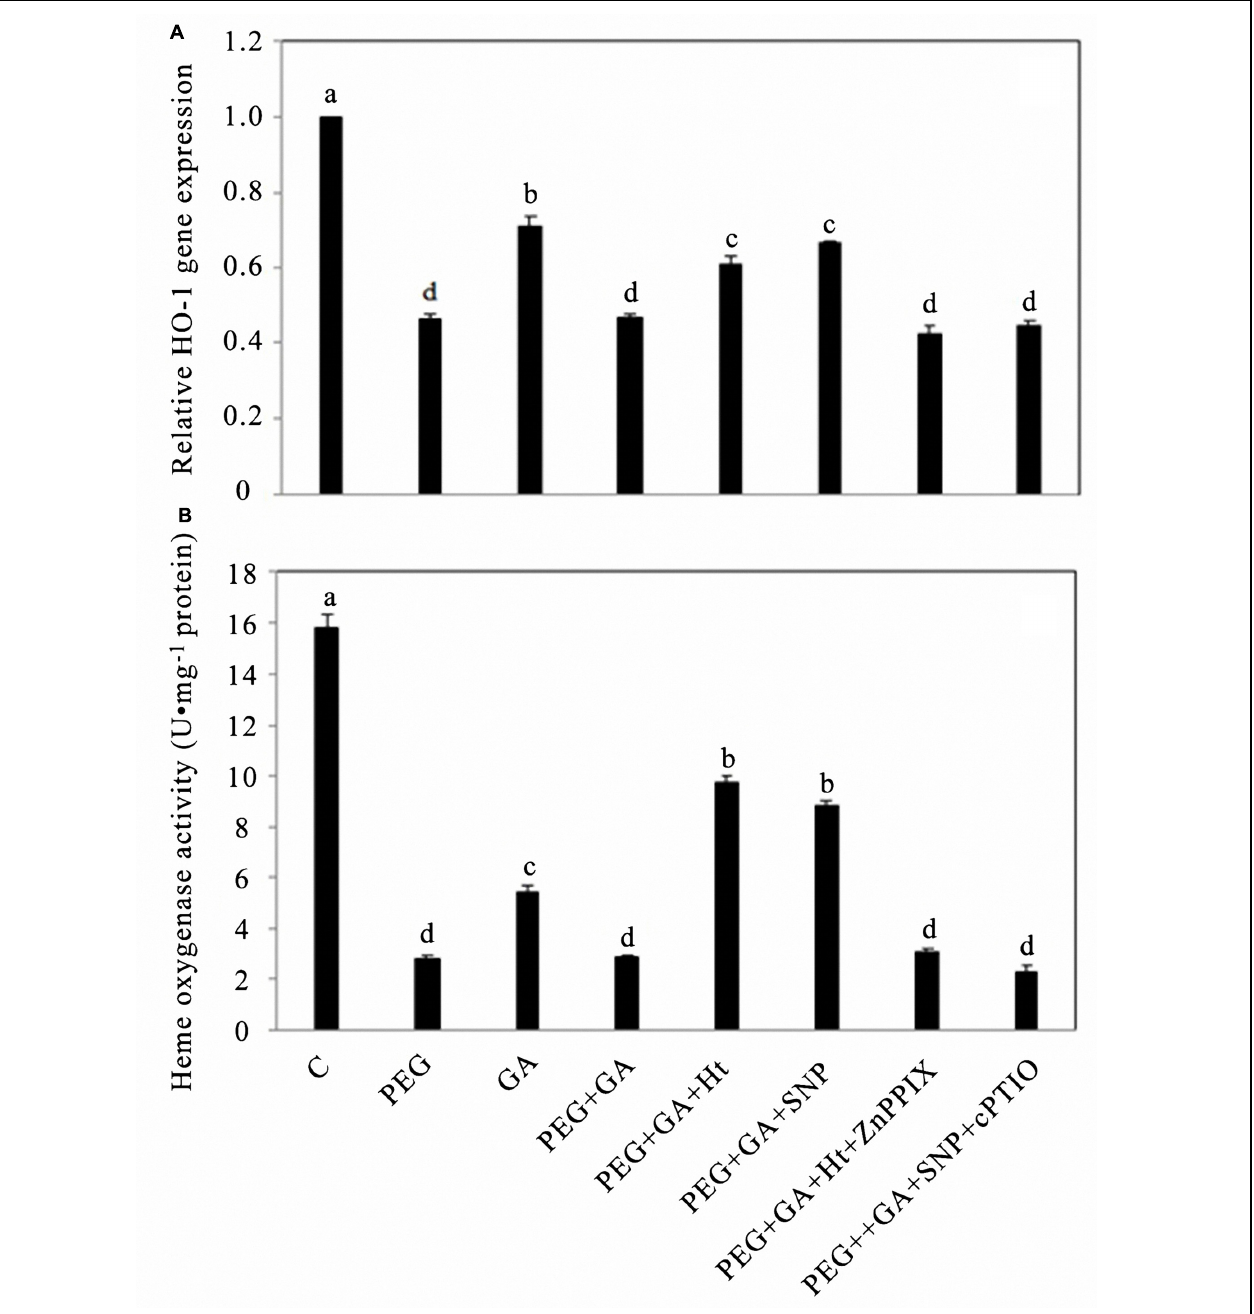
FIGURE 3 | Ht, SNP, ZnPPIX, and cPTIO up- or down-regulated the expression of HO-1 and the activity of HO in GA-induced rice aleurone layers subjected to drought stress. Aleurone layers treated with or without 20% PEG, 50 μ M GA, 1 μ M Ht, 200 μ M SNP, 10 μ M ZnPPIX, and 200 μ M cPTIO alone or in combination for 24 h. A sample with distilled water treatment was used as control (C). The transcript levels of HO-1 analyzed by real-time fluorescence quantitative PCR at 24 h. The expression levels of the HO-1 gene are presented as values relative to that of the control (A) . Meanwhile, the corresponding HO activity (B) was determined after different treatments for 24 h. Mean values were calculated from at least three independent experiments, bars with different letters indicate significant differences at the 0.05 level, according to Duncan’s multiple